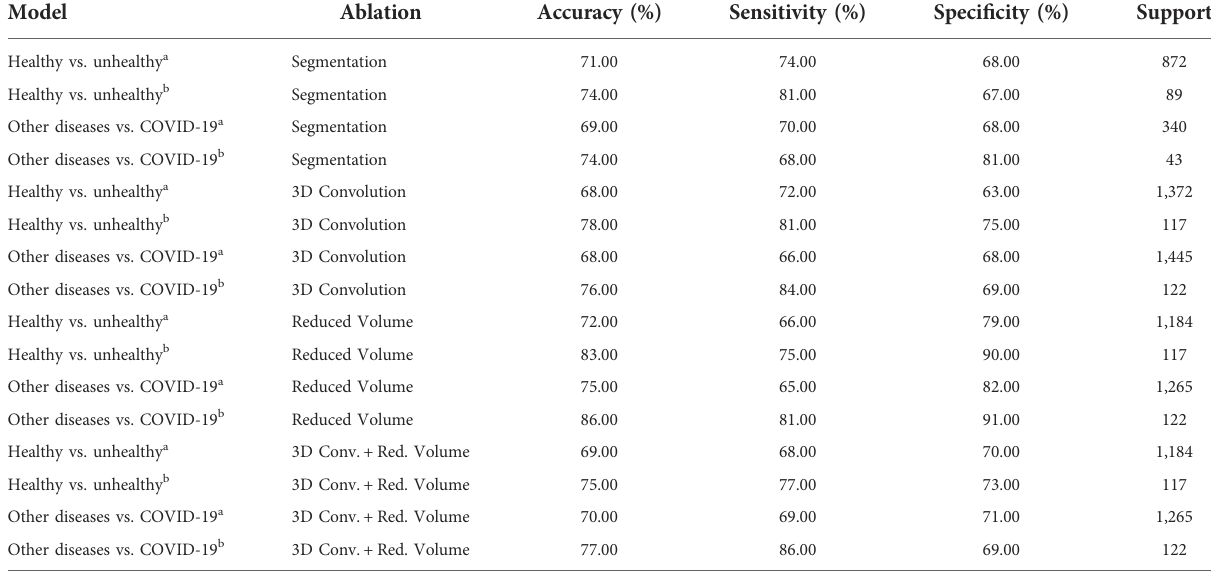
TABLE 3 Ablation studies